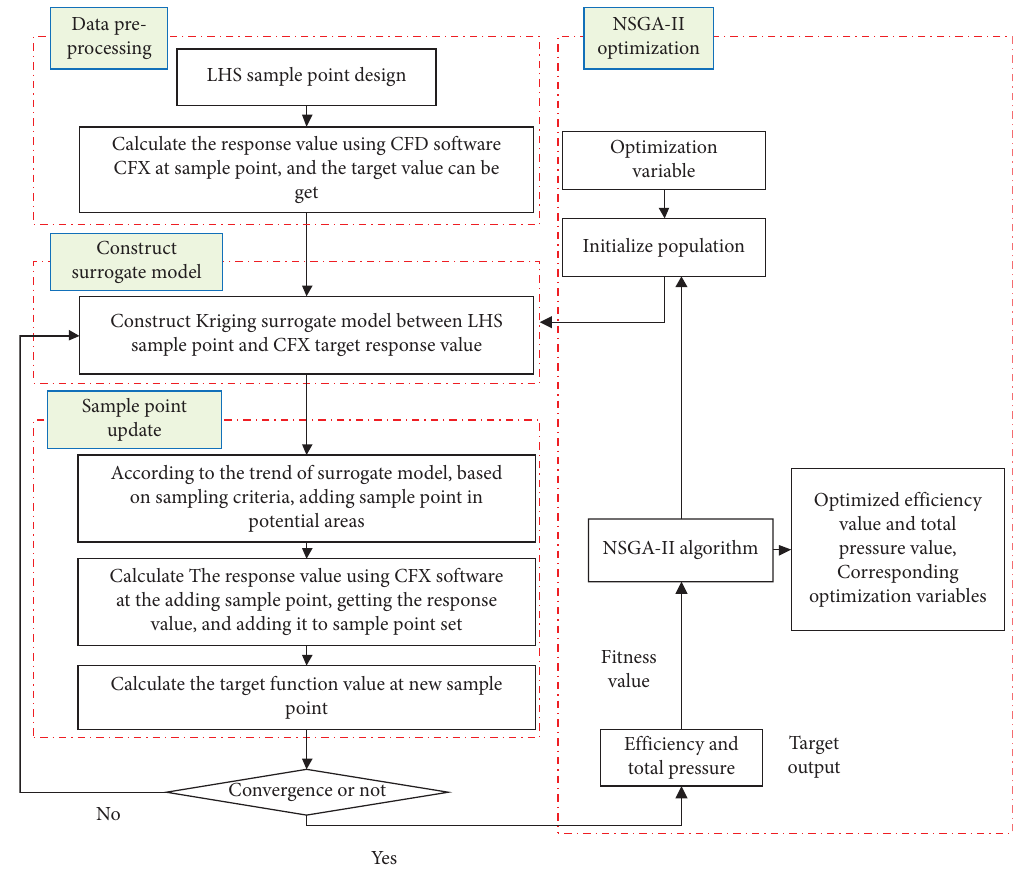
Figure 1: Self-adaption surrogate model optimization